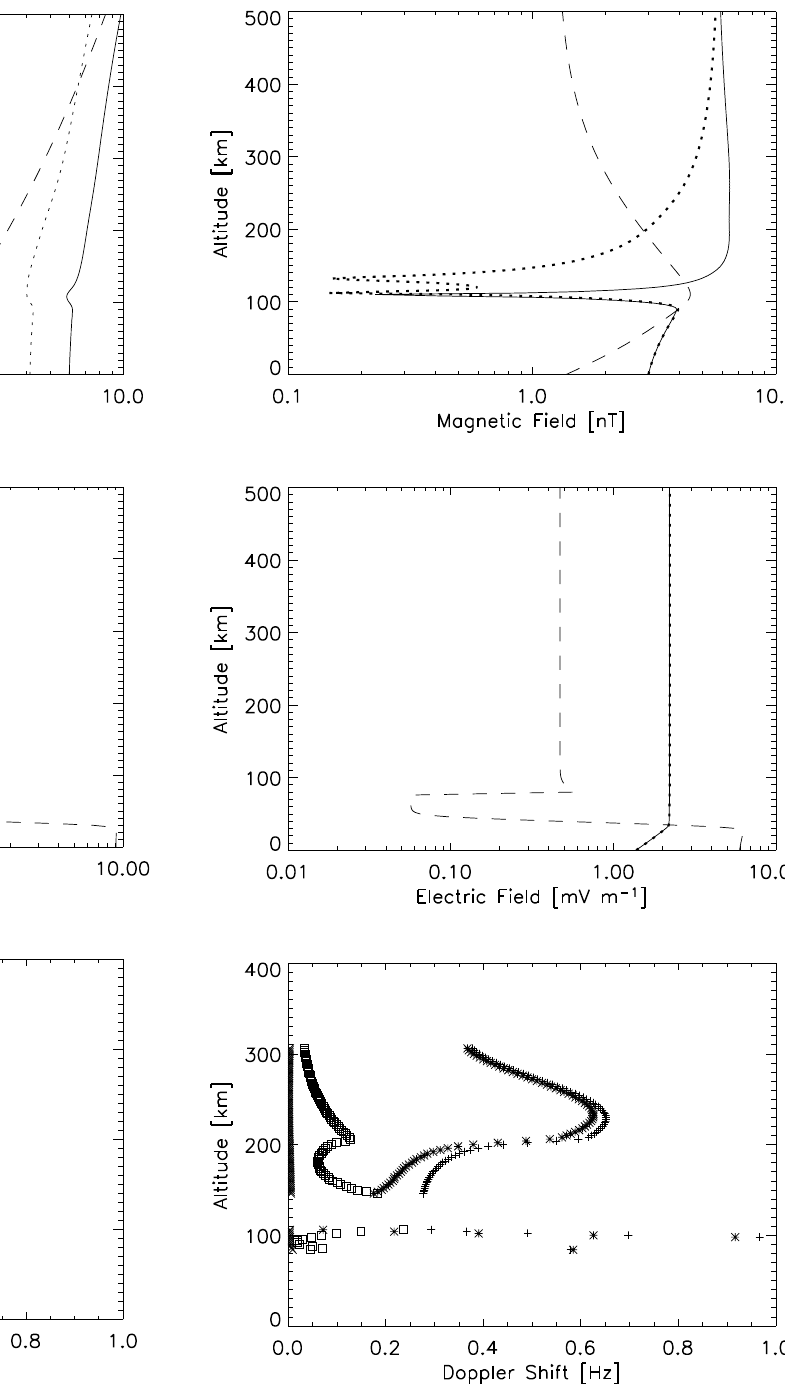
Fig. 8. Model results of the ULF electric and magnetic fields and the associated Doppler shift with altitude. The parameters associ- ated with 04:30–05:30 UT, 24 March 2001 were used. (a) ULF wave magnetic field magnitudes where b x (solid), b y (dotted), b z (dashed). (b) ULF wave electric field magnitudes where e x (solid), e y (dotted), e z (dashed). (c) Doppler shifts where V 1 (X), V 2 (+), V 3 (squares) and V ∗